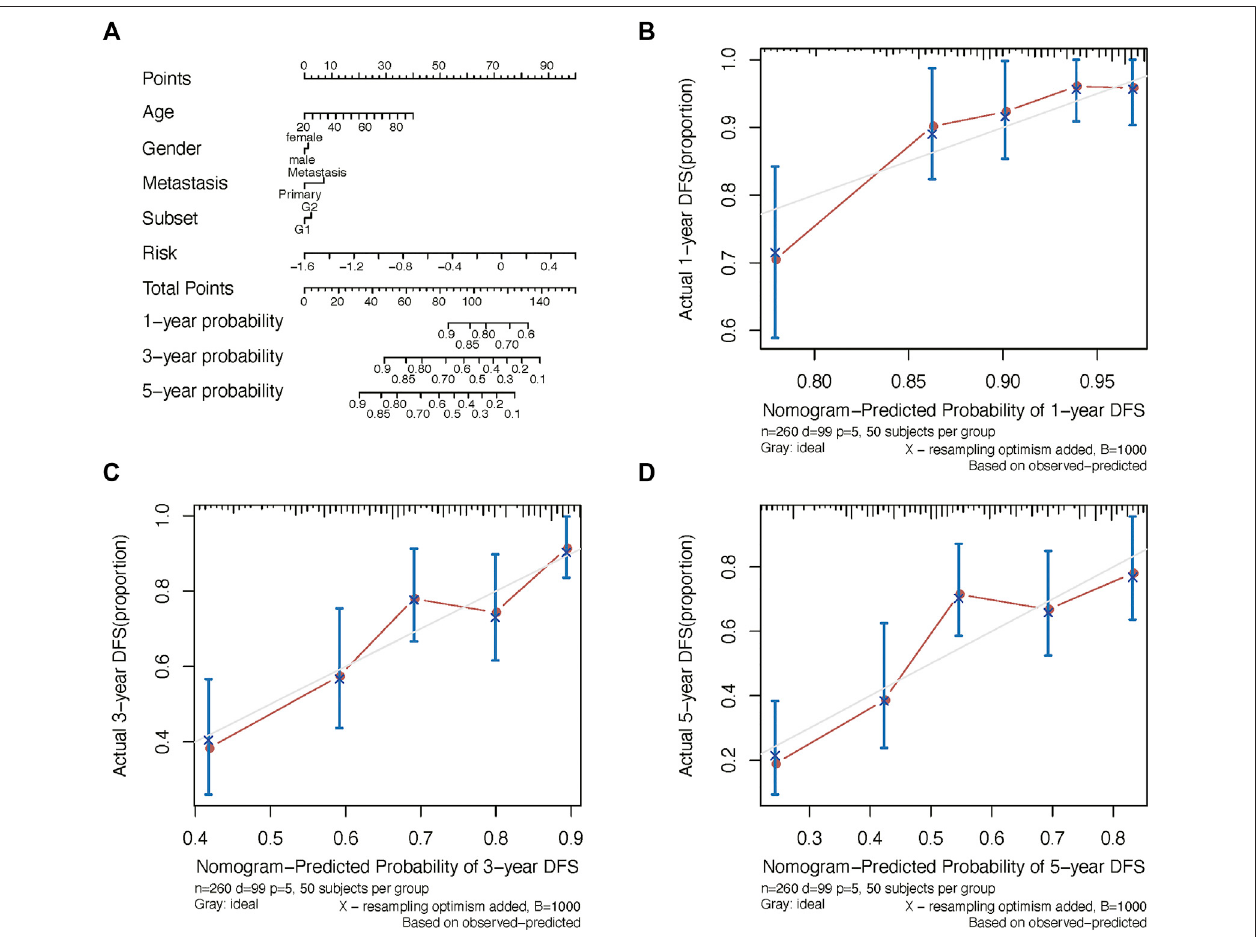
FIGURE 5 | Nomogram analysis. (A) Nomogram composed of age, gender, and risk score for the prediction of 1-, 3-, and 5-years OS probability. Calibration plot for the evaluation of the nomogram in predicting 1-year (B) , 3-years (C) , and 5-years (D) OS probability.